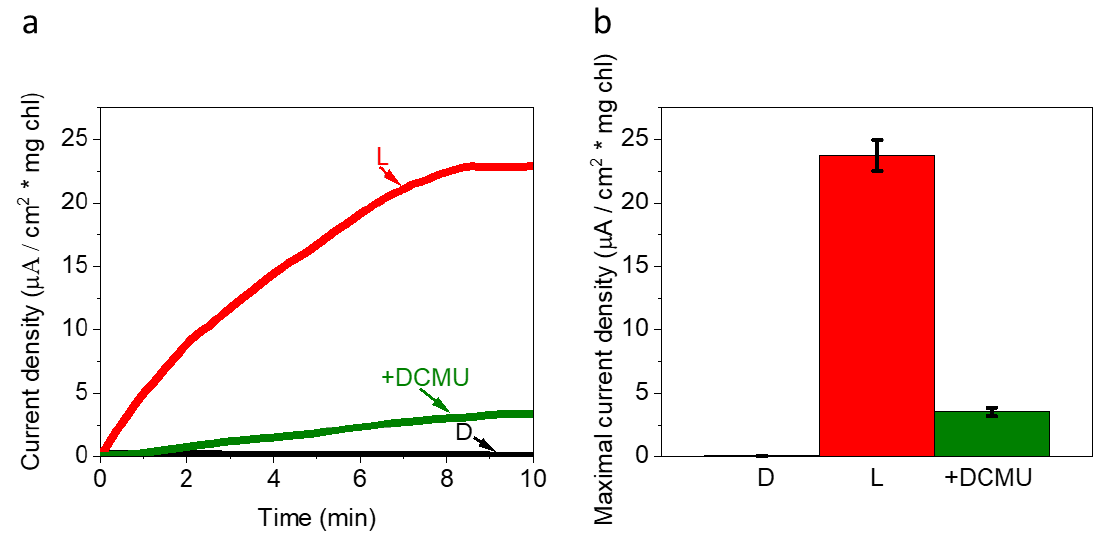
Figure 1. Live Ds cells in high salt produce photocurrent that originates from PSII. CA measurements of live Ds were conducted in 1.5 M NaCl with an applied bias of 0.5 V on the anode in dark, light, and in light in the presence of 100 µM DCMU. ( a ) CA in dark (D), light (L), and in light with DCMU (+DCMU). ( b ) Maximal current densities after 10 min of CA in dark (D), light (L), and in light with DCMU (+DCMU). The error bars represent the standard deviation over three independent